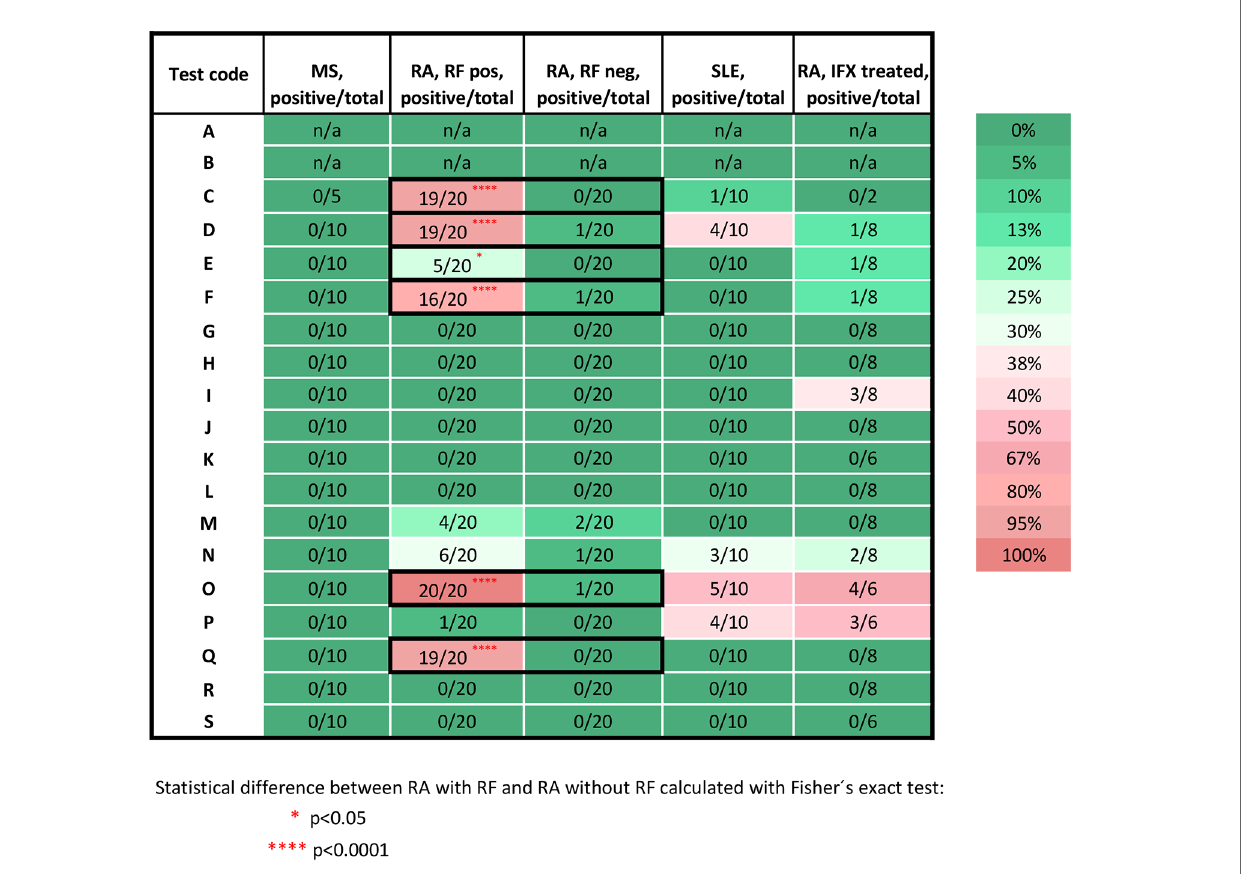
( Table S1 ). Three of the SLE patients were IgA RF positive and